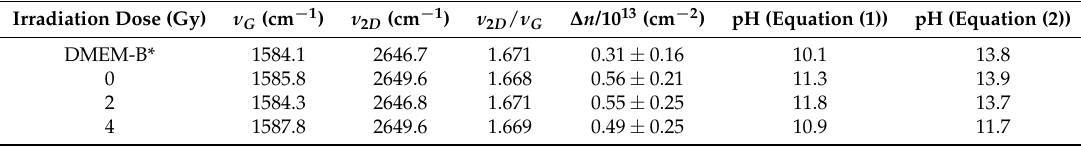
Table 2. Experimental results for DMEM-B extracted cultures of the SH-SYSY cell line exposed to different X-ray doses. DMEM-B ∗ indicates samples that had no contact with cells. Irradiation Dose (Gy)